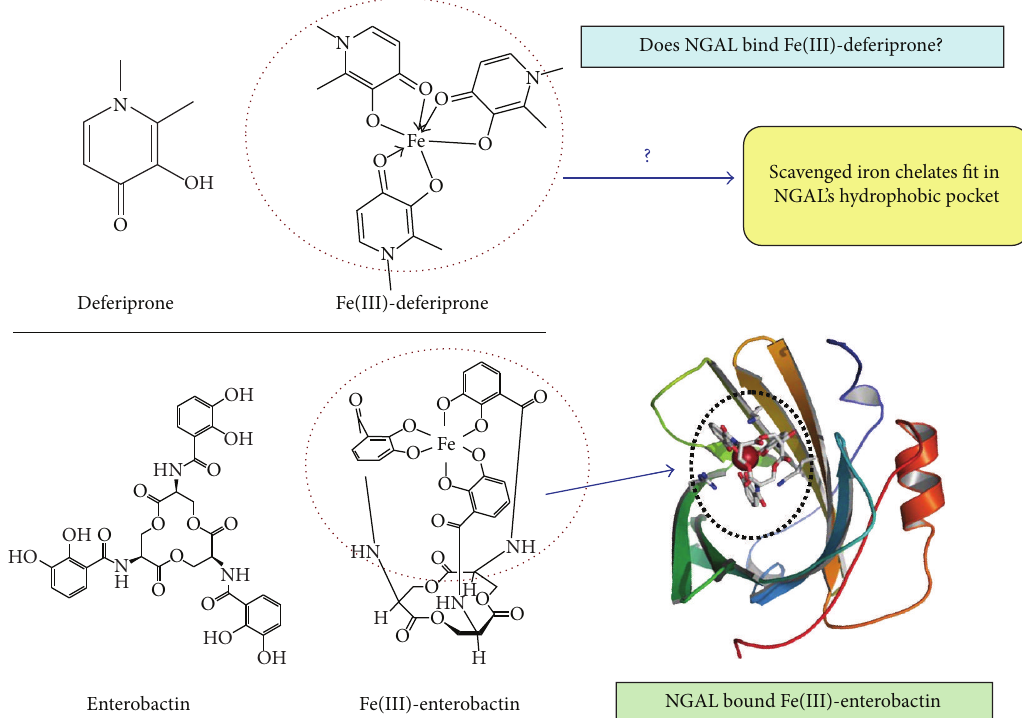
Figure 10: A schematic presentation of proposed small molecule iron chelator acting similar to the mammalian siderophore 2,5- dihydroxybenzoic acid. The DFP-iron complex shares structural resemblance to enterobactin, the major bacterial siderophore that binds iron with very high affinity. As a defense mechanism, the host upregulates NGAL expression to scavenge enterobactin which in turn limits iron availability and inhibits bacterial growth. DFP is an iron chelating small molecule drug that gains access to cells and scavenges free intracellular iron and then exits as a DFP-iron complex. Based on the structural resemblance to enterobactin-iron complexes, the DFP-iron complex is expected to bind NGAL by fitting into the hydrophobic pocket [79]. Therefore, small molecule iron chelators may act as the mammalian siderophore and redistribute iron retained in